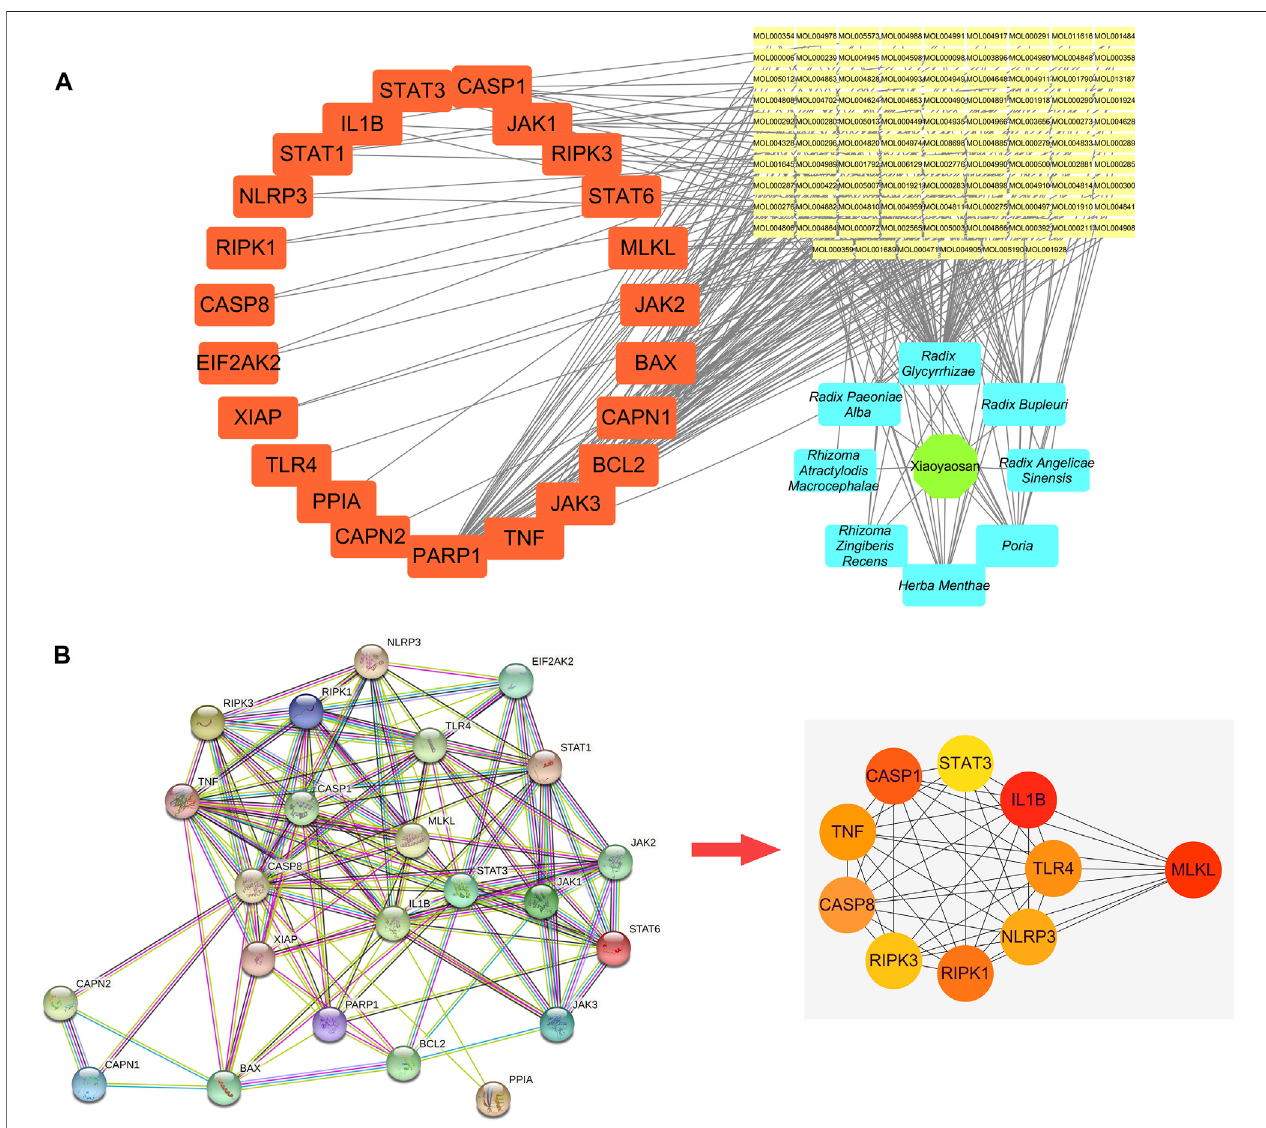
FIGURE4| “ Botanicaldrugs-activeingredients-potentialtargets ” networkandPPInetworkofpotentialtargetgenesofXiaoyaosan (A) The “ Botanicaldrugs-active ingredients-potential targets ” network: These eight botanical drugs of TCM formula Xiaoyaosan had 96 active ingredients which could regulate the 23 key target genes according to the network pharmacological analysis (B) PPI network of the 23 key target genes: The sub-network of the top 10 core targets was picked up from the PPI network of potential target genes of Xiaoyaosan using the cytoHubba plugin in Cytoscape software.